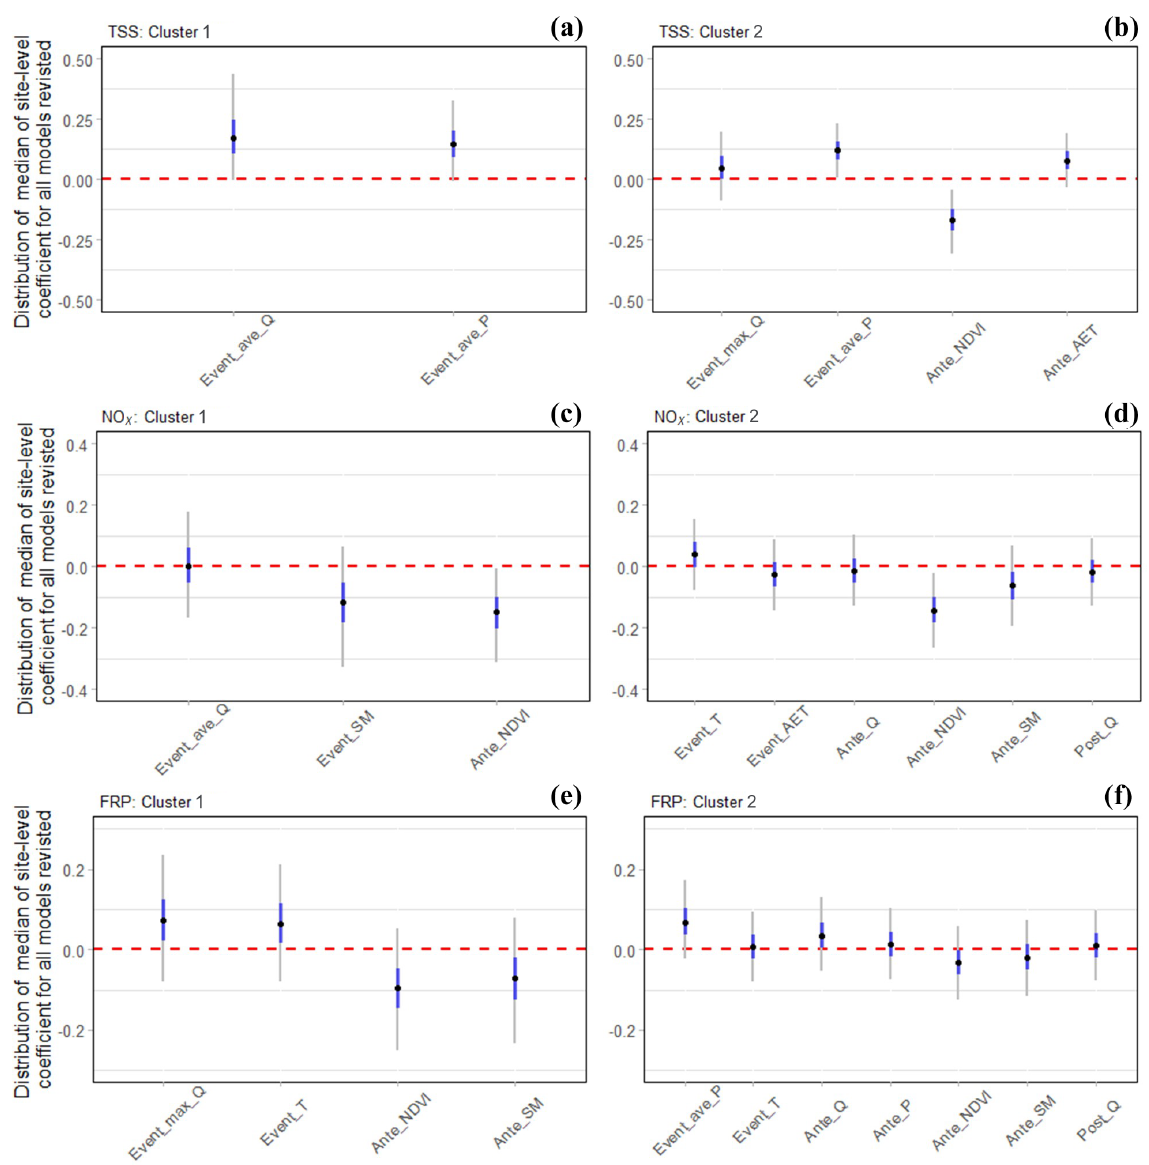
Figure 6. Distribution of median of site-level coefficients for all plausible models in BMA between cluster 1 (wet – a,c,e ) and cluster 2 (dry – b,d,f ) sites for (a) TSS, (b) NO x and (c) FRP. Only predictors with PIP >0.8 are included. For each specific model structure, the coefficient value of a predictor was the median of the site-specific coefficient across all sites (effect size, θ n,j , in Eq. 6). The distribution of this value thus represents the probability of the model (PMP) and the variability in the same predictor across different sites. Black dots show the median, grey vertical lines show the 95% CI, and blue coloured vertical lines show the 50% CI. The definitions of the abbreviations of each predictor on x axes are given in Table